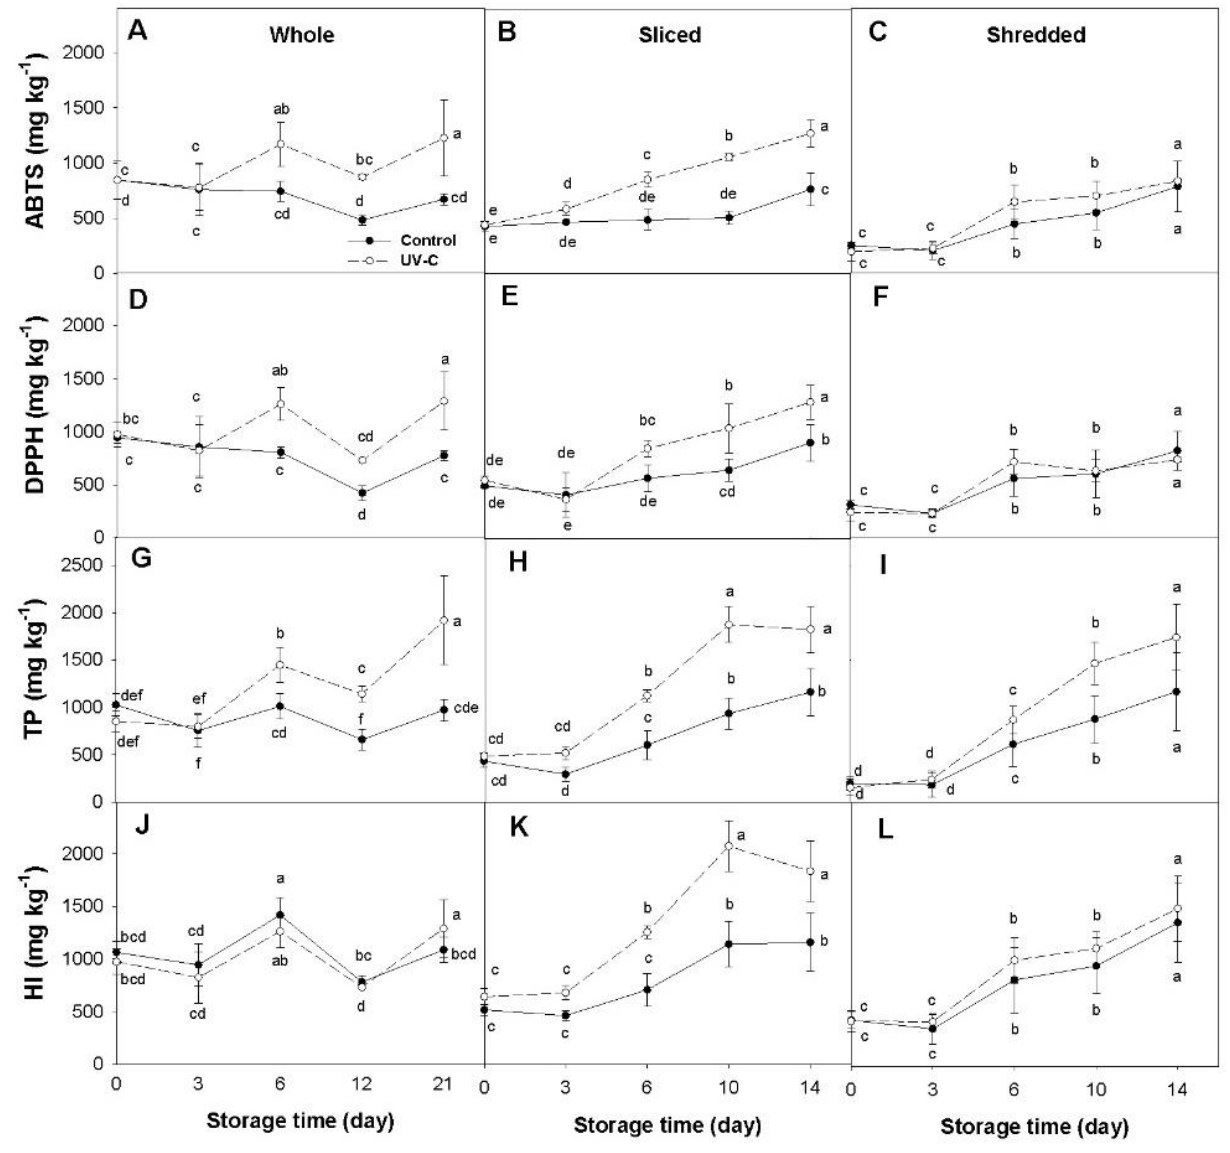
Figure 1. Time-course variation for mean antioxidant capacity determined by the ABTS ( A – C ) and DPPH ( D – F ) methods, concentration of total phenolics (TP) ( G – I ), and hydroxycinnamic index (HI)